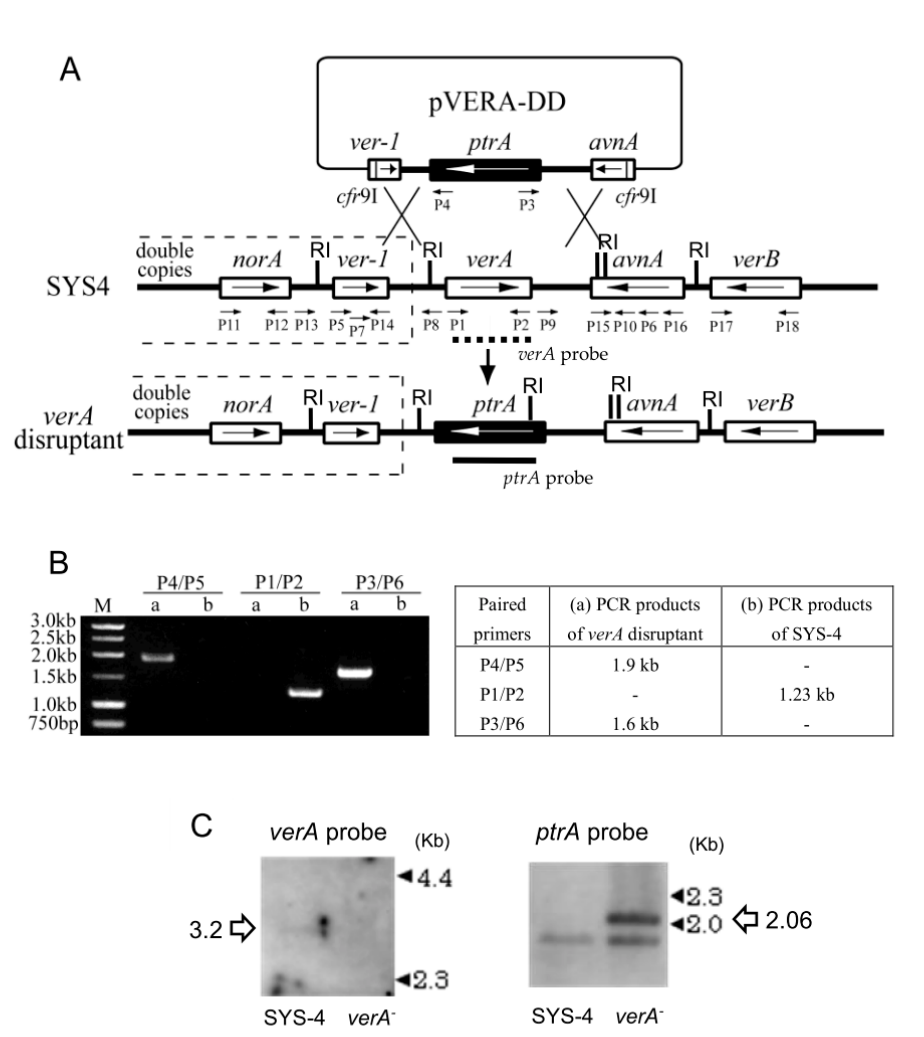
Figure 2. Disruption of verA gene. ( A ) The strategy for the disruption of the verA gene. The double-crossover recombination events resulted in the replacement of the verA gene with the selectable marker ptrA gene. Long arrows: gene direction, short arrows: position of primers used for the confirmation of gene disruption. ( B ) A PCR analysis using different combinations of primers was done to confirm whether the verA gene was deleted in the verA disruptant. The PCR products obtained with the primer pairs (as shown in the table) were used to confirm the verA disruption. M, 1-kb molecular marker. ( C ) Southern analysis of the verA disruptant. Genomic DNA of strain SYS4 (wild stain) or the verA disruptant were digested with Eco RI and analyzed by Southern hybridization using the verA probe (left) or ptrA probe (right). The positions of the size markers are indicated by closed triangles. The sizes of the resulting fragments are indicated by open arrows.